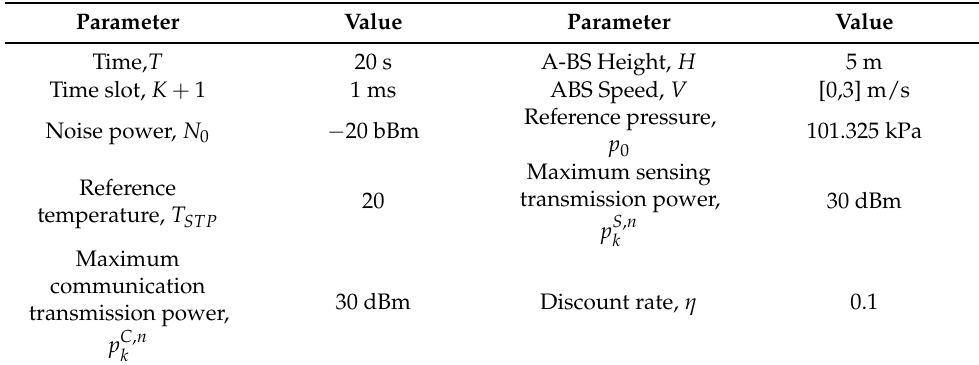
Table 2. Simulation parameters.